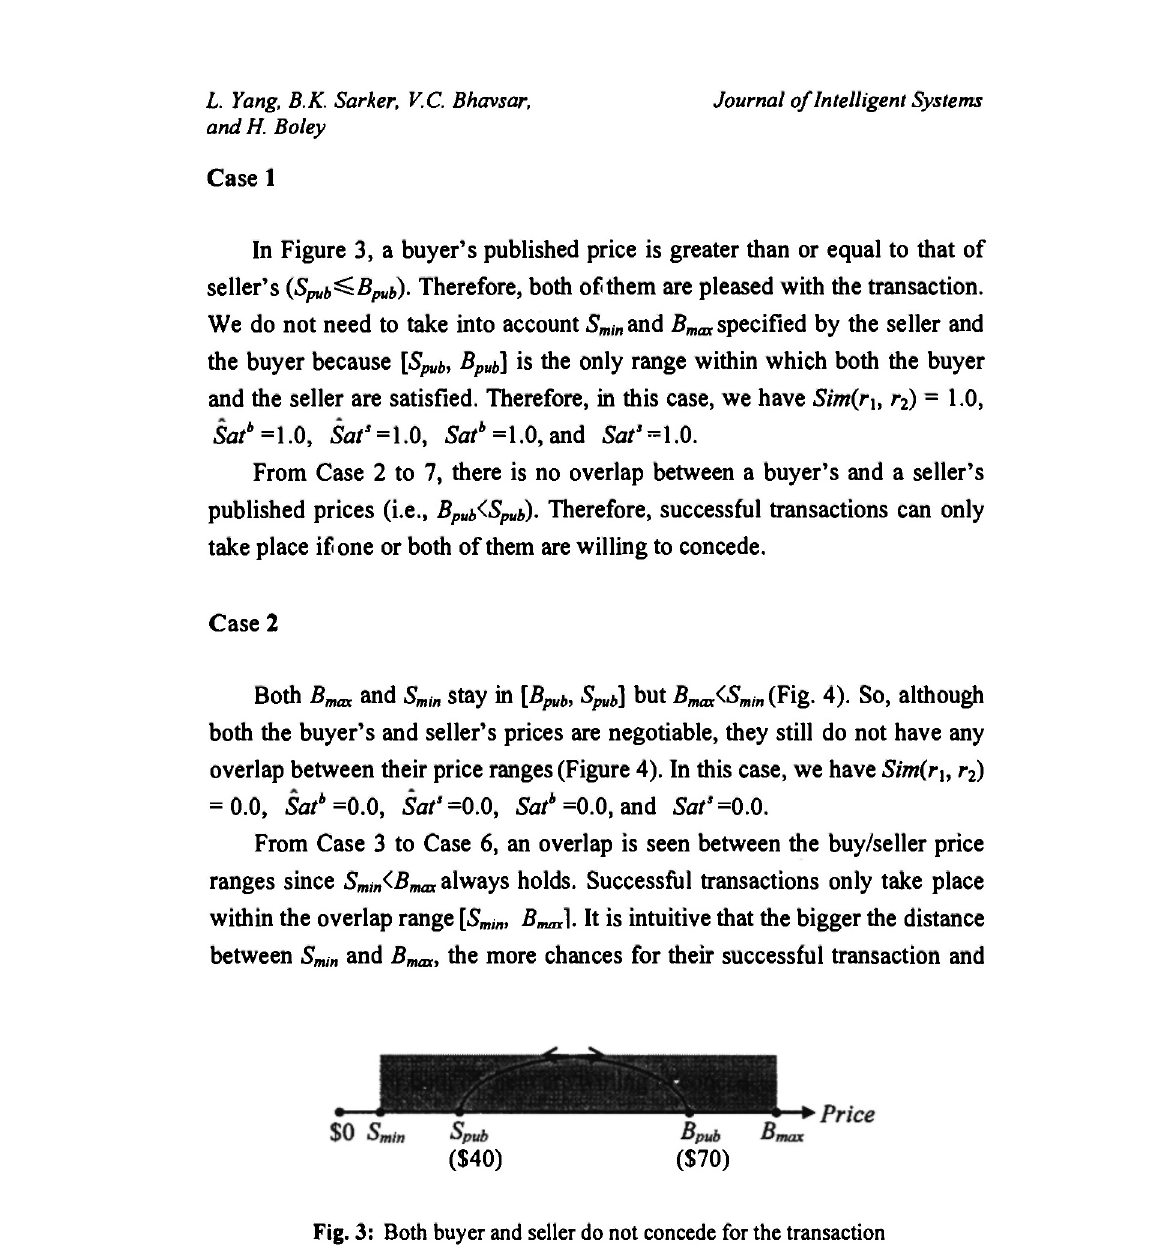
Fig. 4: Buyer's and seller's price ranges do not overlap even after concession